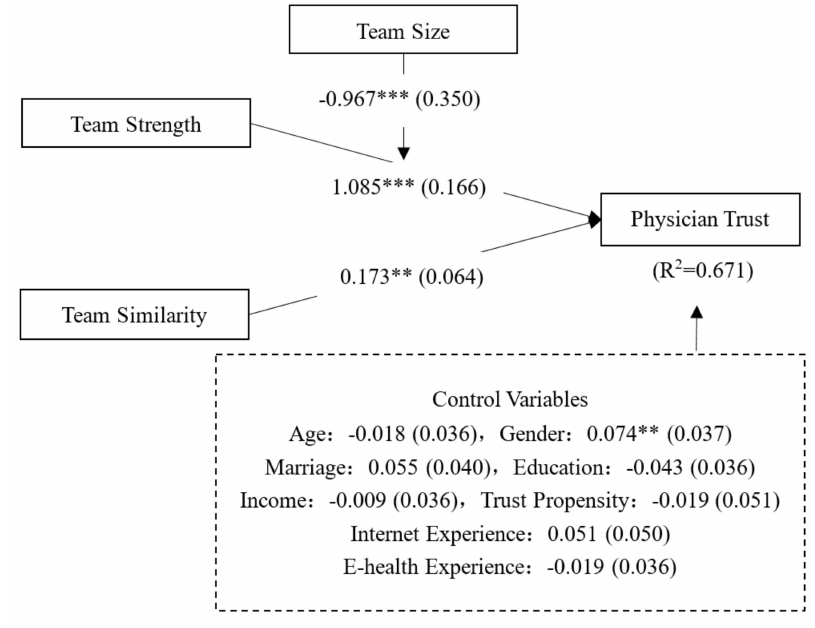
Figure 4. PLS analysis results. *** p < 0.001, ** p < 0.01, * p <